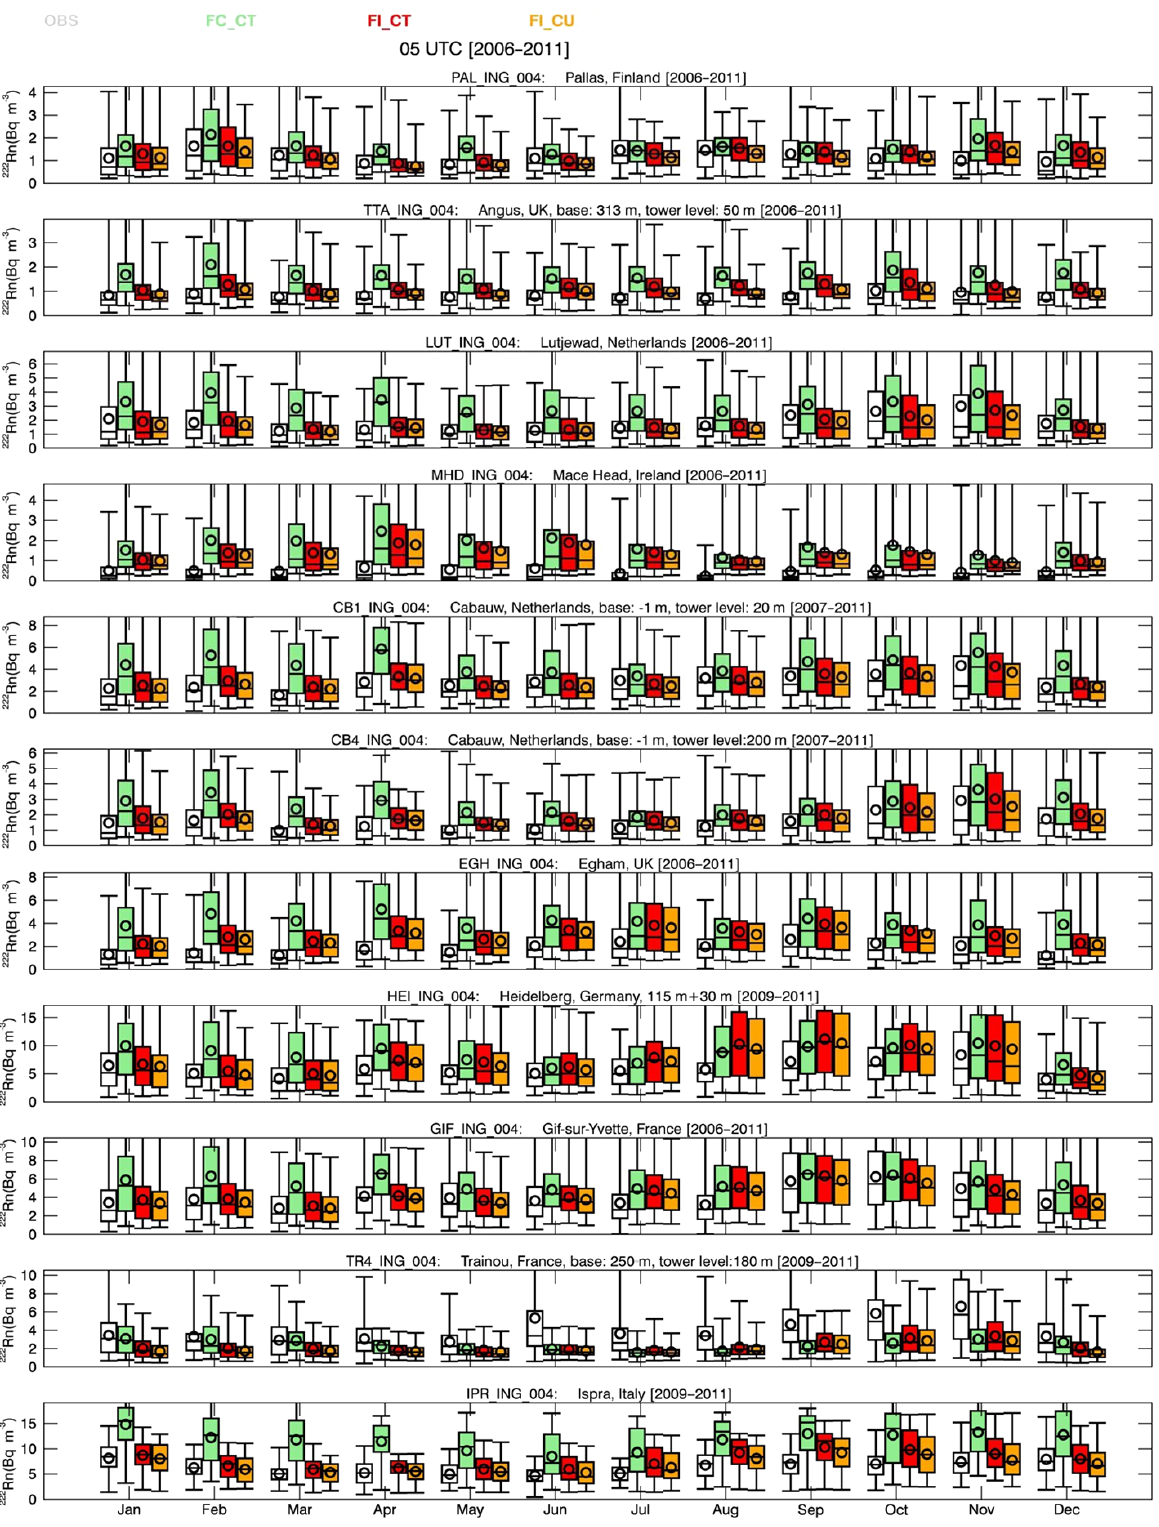
Figure 6. Seasonal variations of daily maximum of observed and simulated radon ( 222 Rn) activity concentrations at InGOS sites at 05:00UTC (2006–2011). The whisker plots show the monthly minimum and maximum values (bars), and the 25 and 75% percentiles (boxes). The median values are given by the horizontal line and the mean values by the open circles in the boxes. The observed radon activity concentrations are shown in blank, and the model simulations are represented by the coloured boxes (the acronyms for the different model simulations are defined in Sect. 3.4). FC uses constant 222 Rn fluxes and FI the InGOS flux